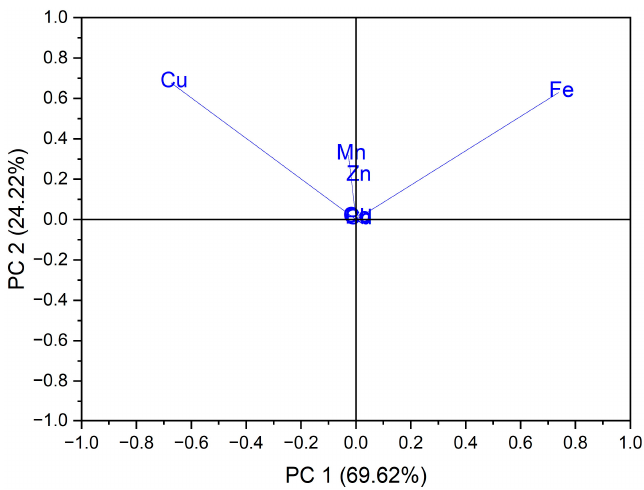
Figure 4. Chart of records of PC2 vs. PC1 for PCA analysis, using as input data the content of trace elements for the analyzed vegetable samples.